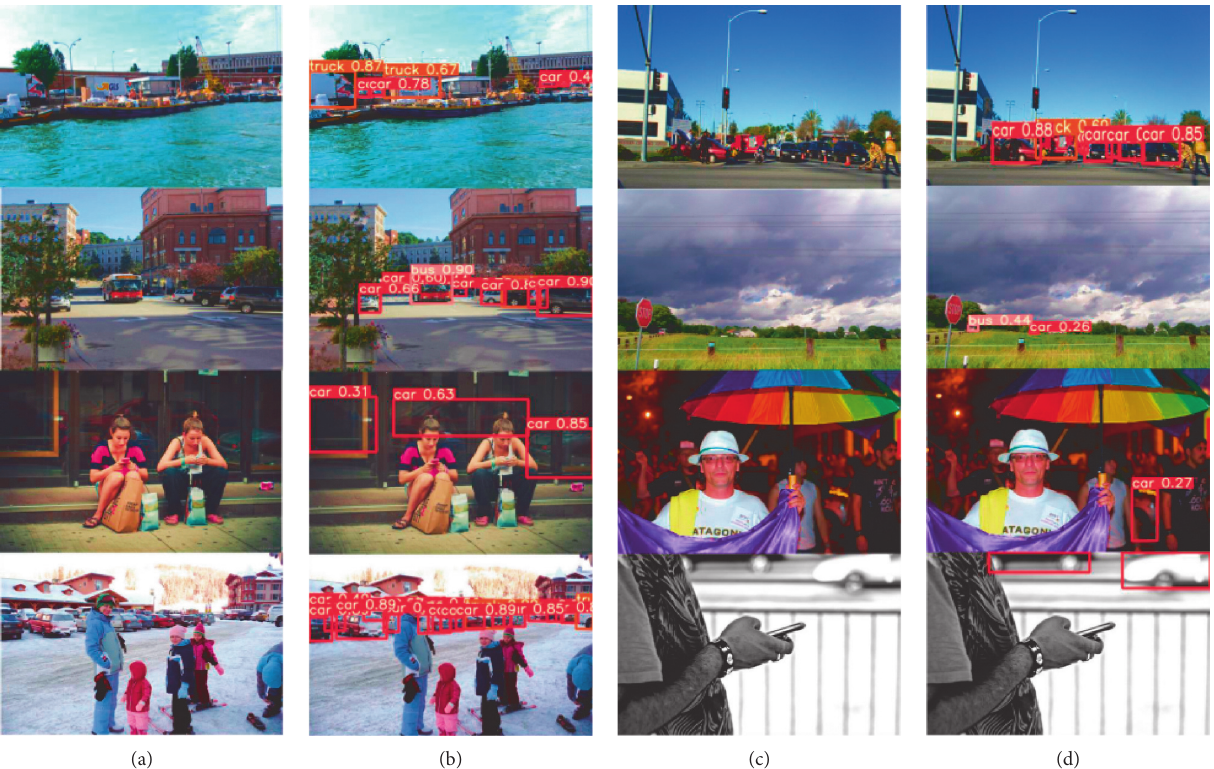
Figure 9: Examples of visualizations. (a, c) The original diagram contains the vehicle at various angles, far and near perspective, and even includes the reflective glass vehicle. (b, d) The result of the visualization of the improved